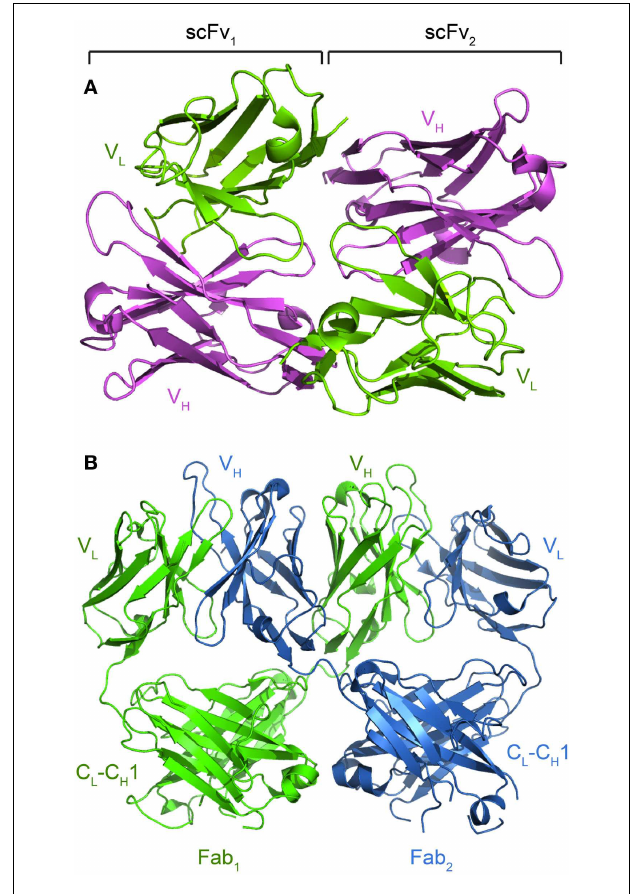
FIGURE 7 | Crystal structures reveal alternative modes of antibody self-interactions. (A) V H -V L interactions are seen for the scFv of MFE-23 (pdb: 1QOK; Boehm et al., 2000). (B) V H domain swapping between the anti-HIV Fab 2G12 (pdb: 1OM3; Calarese et al.,